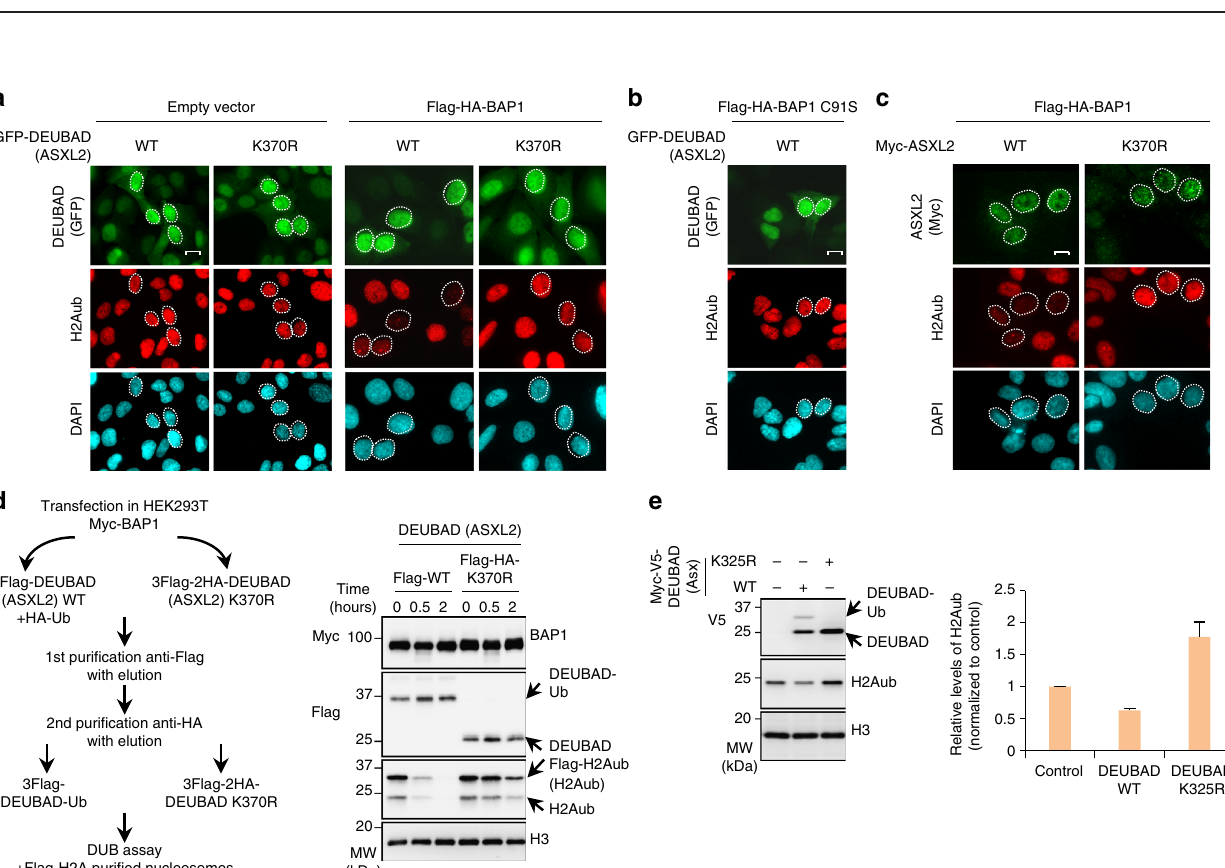
Fig. 6 Dual role of UBE2E family in regulating ASXL2 protein stability. a Depletion of UBE2E3 results in increased DEUBAD (ASXL2) protein levels. U-2 OS cells stably expressing GFP-DEUBAD (ASXL2) were transfected with a different siRNAs oligos for UBE2E3 and then treated with CHX as indicated. Right panel, densitometry analysis of DEUBAD protein bands was conducted and presented as indicated. n = 3 biological replicates. b Combined depletion of all three UBE2Es resulted in a stronger increase of DEUBAD (ASXL2) protein levels which become similar to those of GFP-DEUBAD K370R. U-2 OS cells stably expressing GFP-DEUBAD (ASXL2) were transfected with Non-target siRNA control or a combination of UBE2Es ( UBE2E1 , UBE2E2 , UBE2E3 ) siRNAs, treated with CHX as indicated and used for immunoblotting. Right panel, densitometry analysis of the protein levels of DEUBAD bands were conducted and presented as in a . n = 3 biological replicates. c Opposite effects of UBE2Es on DEUBAD (ASXL2) and ASXL2 protein levels depending on BAP1 expression. Flag-UBE2Es expression constructs were transfected in HEK293T cells in the presence of Myc-DEUBAD (ASXL2) or Myc-ASXL2 expression vectors in presence or not of BAP1 and cells were harvested for immunoblotting. n = 3 biological replicates. d Depletion of UBE2E1, UBE2E3 and the combination of three UBE2Es resulted in decreased protein levels of endogenous ASXL2 and BAP1. U-2 OS cells were transfected with Non-target control (NT) or UBE2E siRNAs and then treated with CHX and used for immunoblotting. Bottom panel, densitometry analysis of ASXL2 and BAP1 levels was conducted and presented for each siRNA. n = 3 biological replicates. e UBE2Es-mediated DEUBAD monoubiquitination is conserved in Drosophila . S2 cells were transfected with dsRNA for Calypso or UBCD2 and Myc-V5-DEUBAD (Asx). DEUBAD monoubiquitination was evaluated by immunoblotting. Bottom panel, densitometry analysis of the protein levels of monoubiquitinated form versus non-modi fi ed form of DEUBAD (Asx). n = 3 biological replicates. The stars in panels a , b , and d indicate UBE2E2 band detected with UBE2E1 antibody. Tubulin was used as a loading control for panels a – d and histone H3 was used as a loading control for panel e . Error bars in panels a , b , d , e represents s.d. (mean